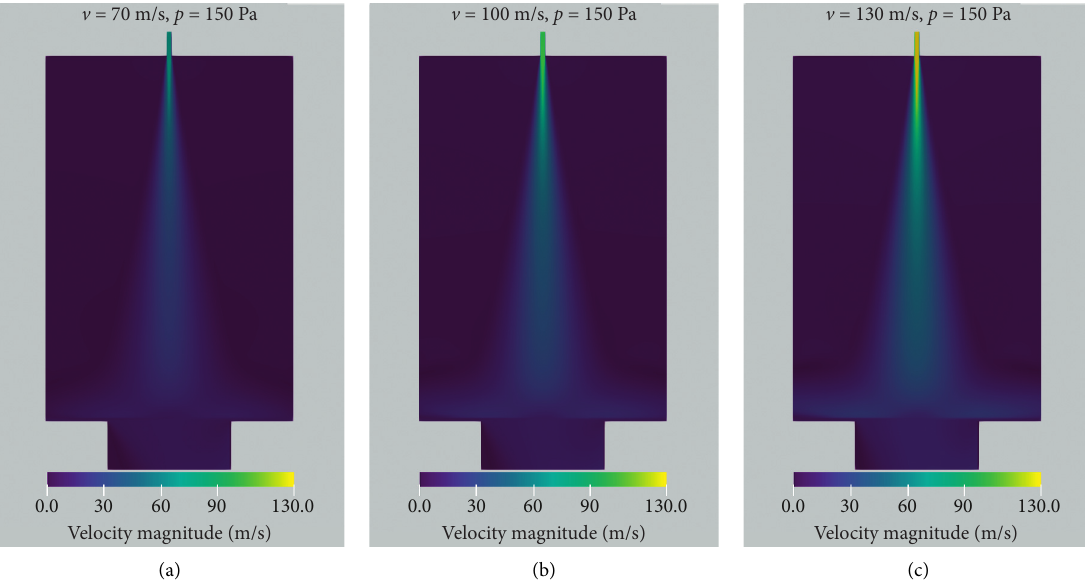
Figure 4: Comparison of air speeds for varying inlet speeds at the end of the drawing unit. (a) 70m/s, (b) 100m/s, and (c) 130m/s, while the absolute pressure of the suction is fixed at p �